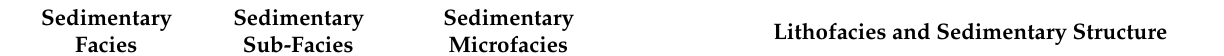
Table 1. Sedimentary facies types, lithofacies and sedimentary structure characteristics of the Shanxi Formation in the study